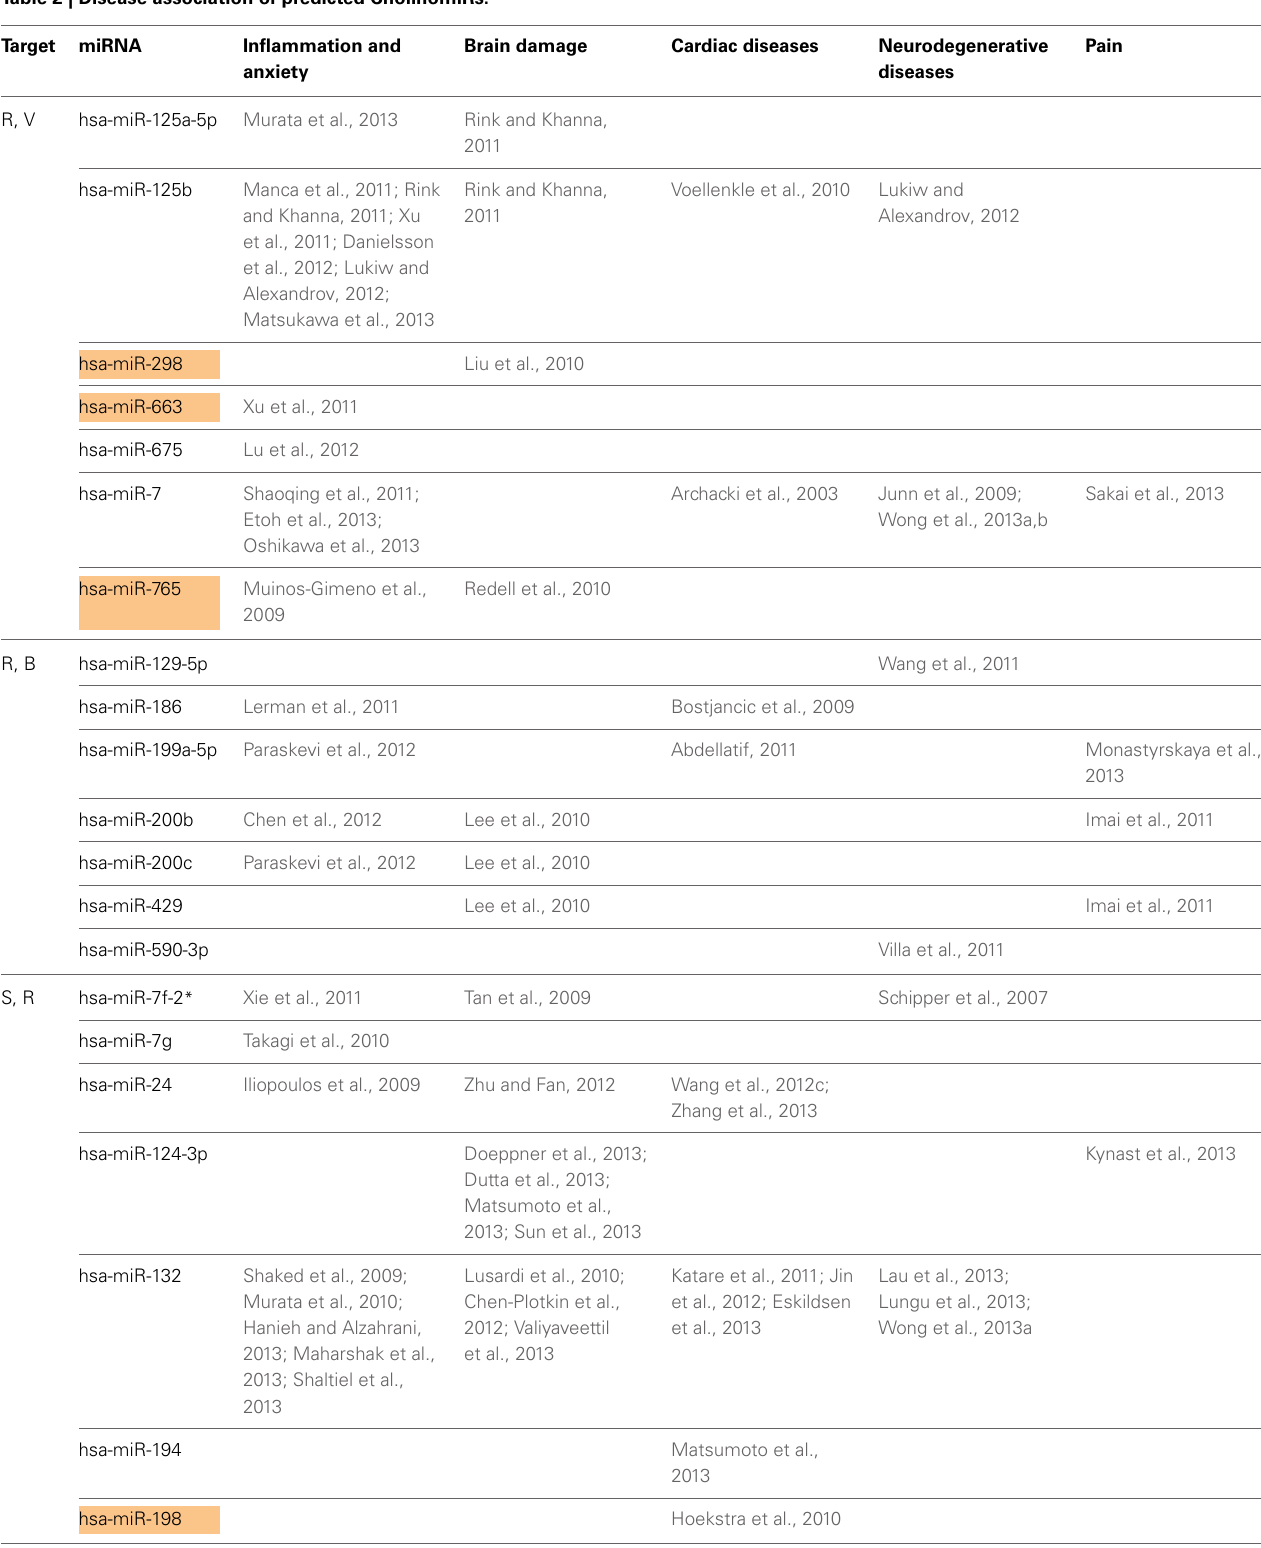
Table 2 | Disease association of predicted